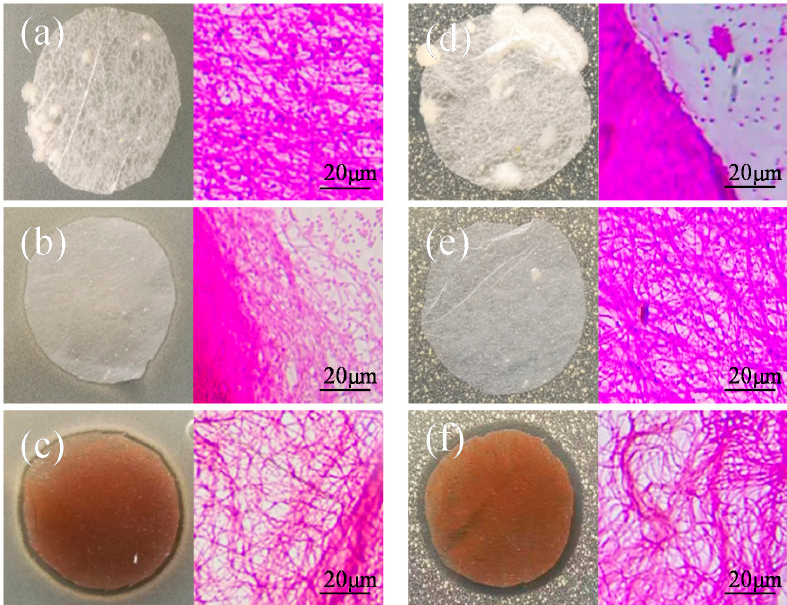
Figure 6. Schematic diagrams of the antibacterial activity of composite nanofibers: ( a – c ) E. coli and ( d – f ) S. aureus . Figure 6a,d, Figure 6b,e, and Figure 6c,f represent Ker.30%/PA6, Ag.1%-Ker.30%/PA6, and Ag.10%-Ker.30%/PA6, respectively. The right-hand images of Figure 6a–f correspond to optical microscopic images. Table 2. Bacterial inhibition zone and bacterial inhibition rate of the AgNP-wrapped Ker.30%/PA6 blend nanofibers mats.